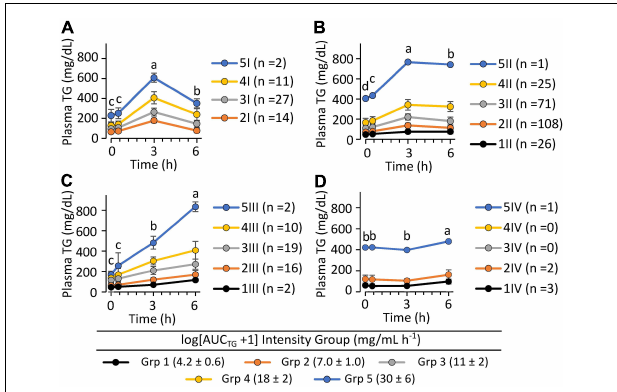
FIGURE 4 | The postprandial triglyceride area under the curve x kinetic response groups among 340 clinically healthy free-living individuals. Data shown are the mean ± SD for the concentrations of the participants identified within five equal intensity groups of the population-wide Log [AUC TG + 1] and one of 4 postprandial kinetic behaviors (Groups I–IV). (A) Group I plasma triglycerides appeared quickly and disappeared rapidly ( n = 54; 16%); (B) Group II plasma triglycerides appeared moderately and disappeared slowly ( n = 231; 68%); (C) Group III plasma triglycerides appeared continuously